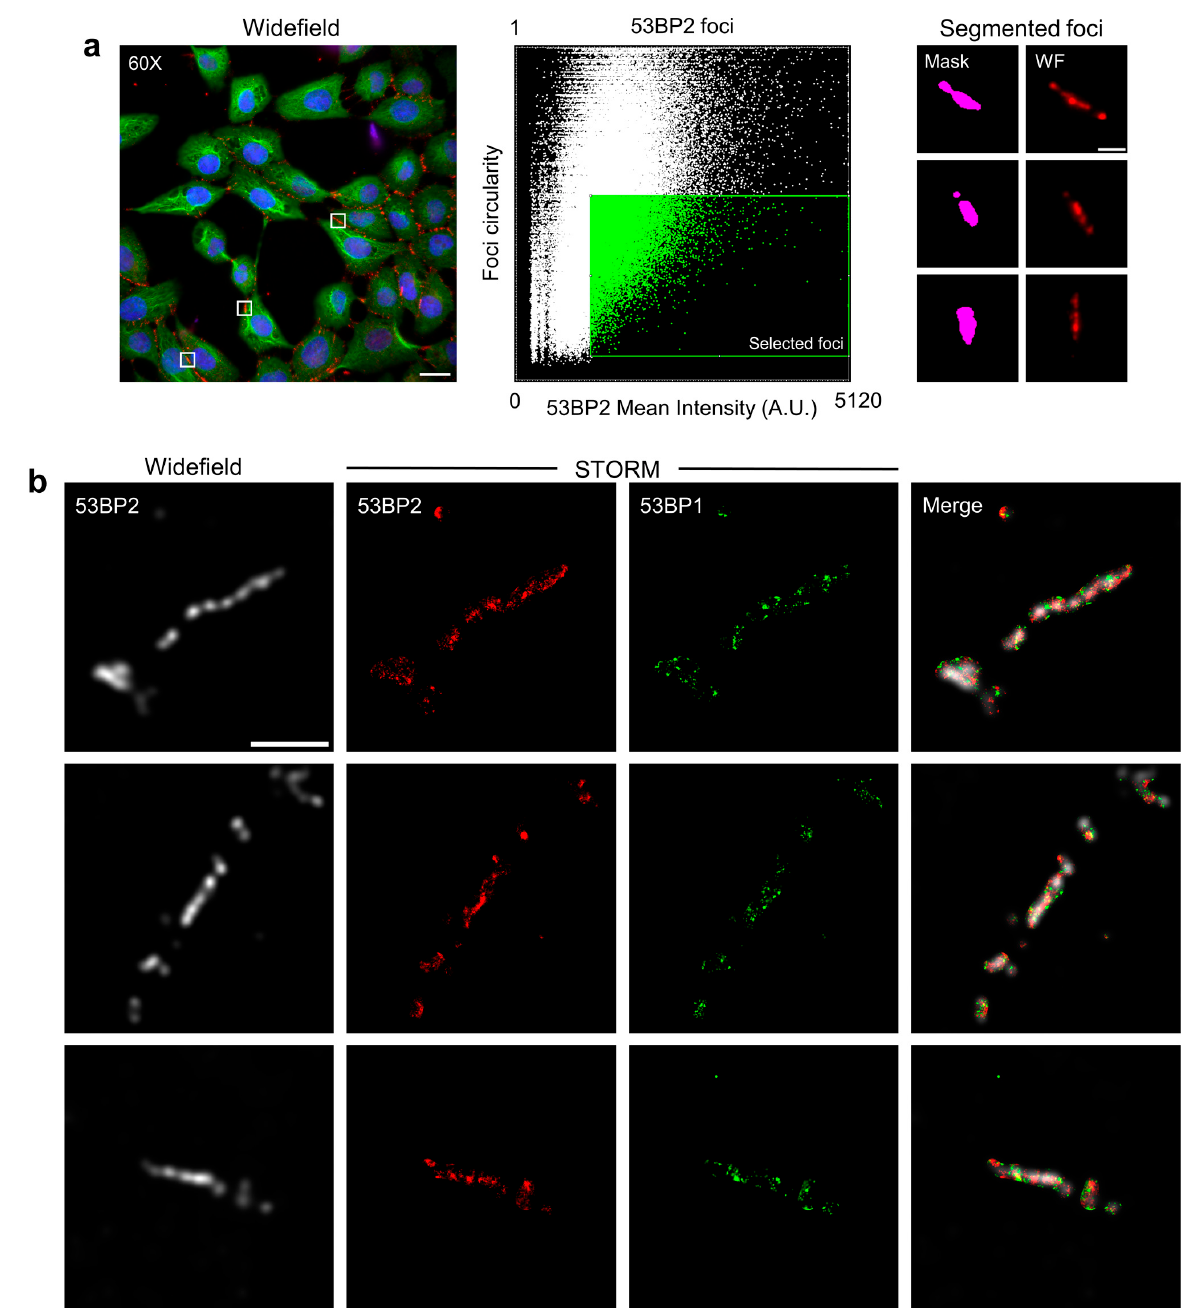
Figure 7. 53BP2 clusters localized at the cell membrane by Image ‐ Cytometry Analysis. ( a ) 53BP2 shows accumulation in elongated structures that can be identified by high mean intensity per pixel and circularity when considering their distribution independently from the cell of origin (dot plot in the middle column). Scale bar: 20 μ m (Widefield), 3 μ m (53BP2 foci). ( b ) Shown are representative images of widefield 53BP2 elongated clusters, re ‐ localized by the intensity ‐ shape analysis, and re ‐ acquired by dSTORM (first column: 53BP2 widefield image, second column: 53BP2, third column: 53BP1, fourth column: merged channels). Scale bar: 3 μ m.